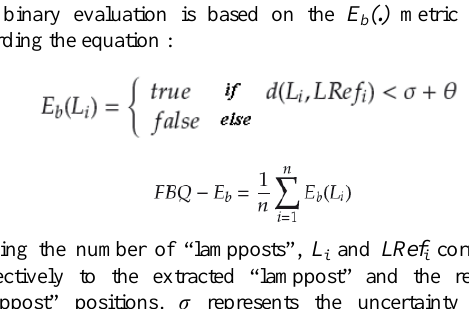
Fig. 8. We extracted the position data of "standard" L i resulting from registration with ICP-SA and R-ICP and compared these positions with reference positions L Ref i according to the formula E b (.) . (a) E b (L (R - ICP)) = true and E b (L (ICP- SA)) = false. (b) E b (L (R - ICP)) = true and E b (L (ICP - SA)) = false. (c) E b (L (R - ICP)) = false and E b (L (ICP - SA)) = false. 3.3.1 Binary approach: E b (.) (3) Radius distance correction